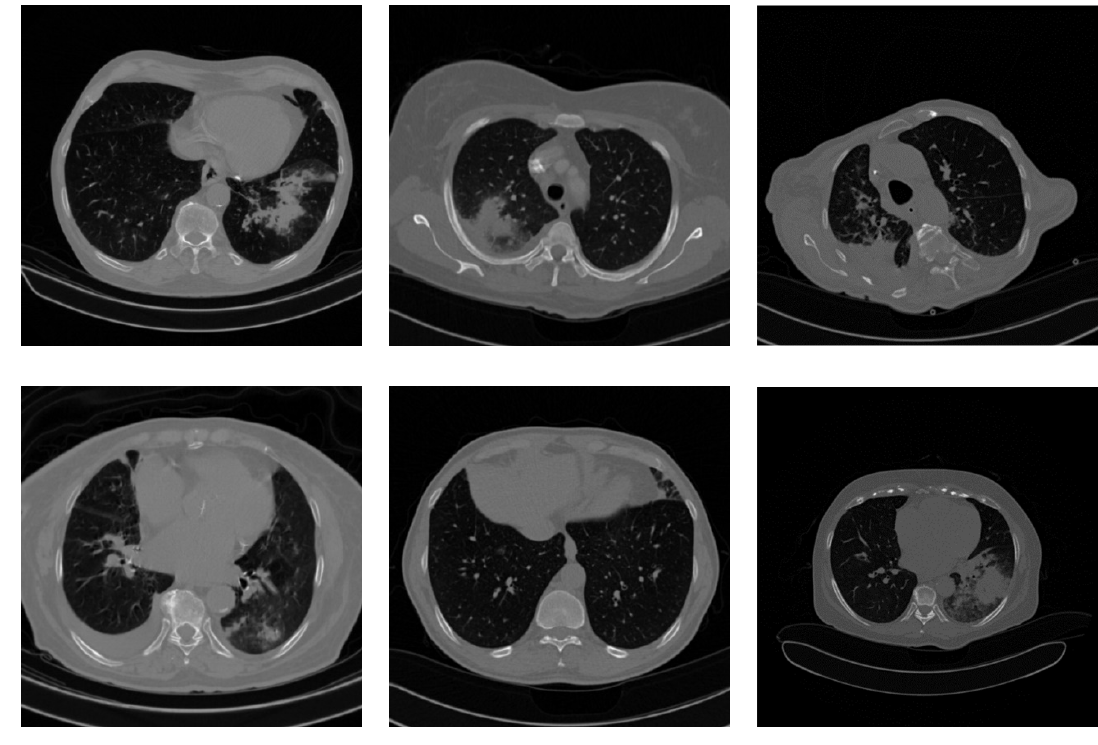
Figure 2. COVID 19 Sample CT scans.